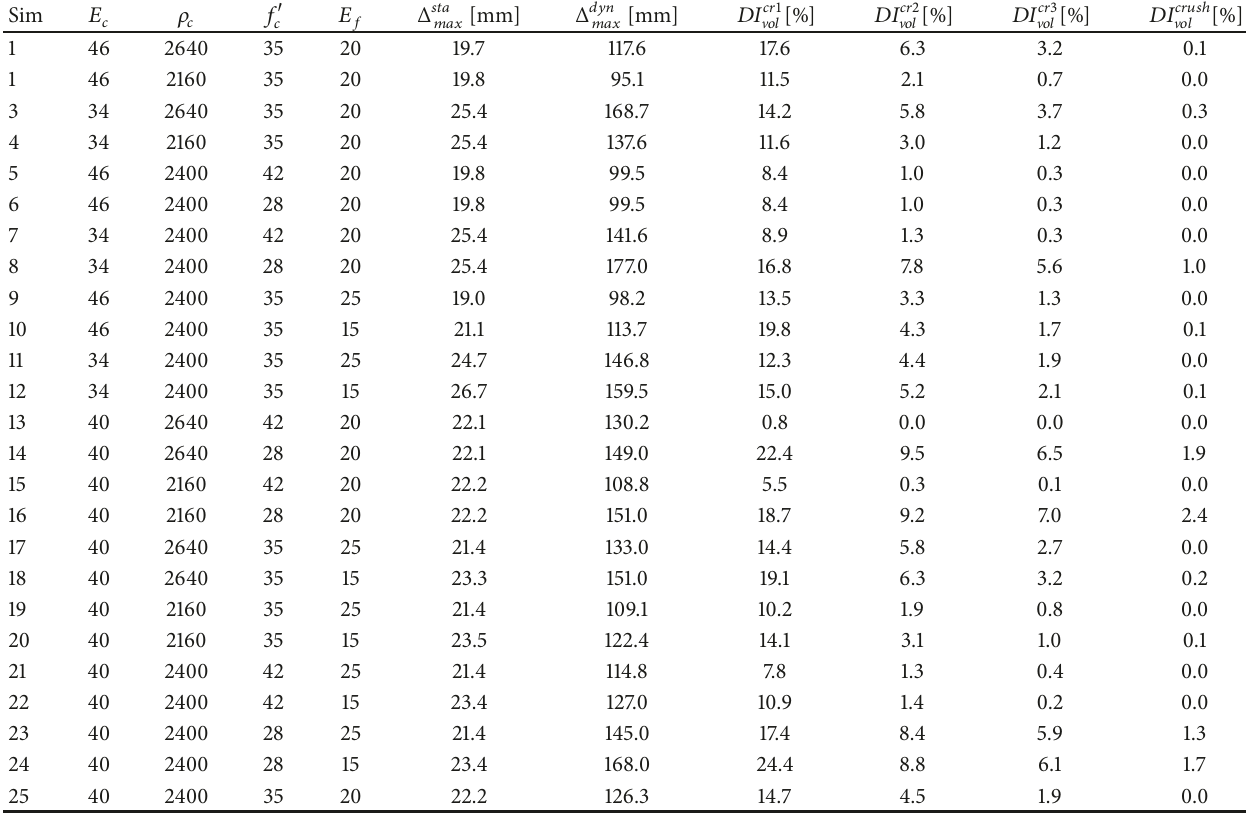
Table 3: Summary of the BBED